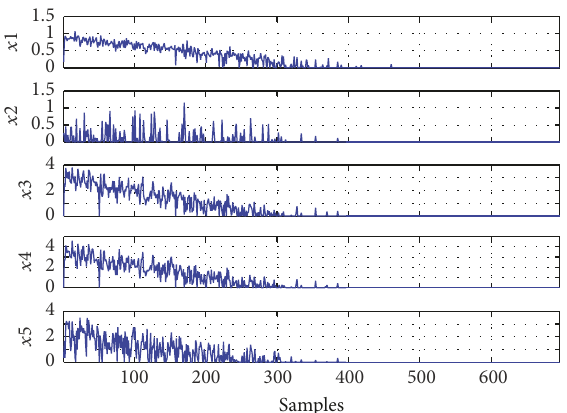
Figure 6: The observations used as input of the NMF algorithm.